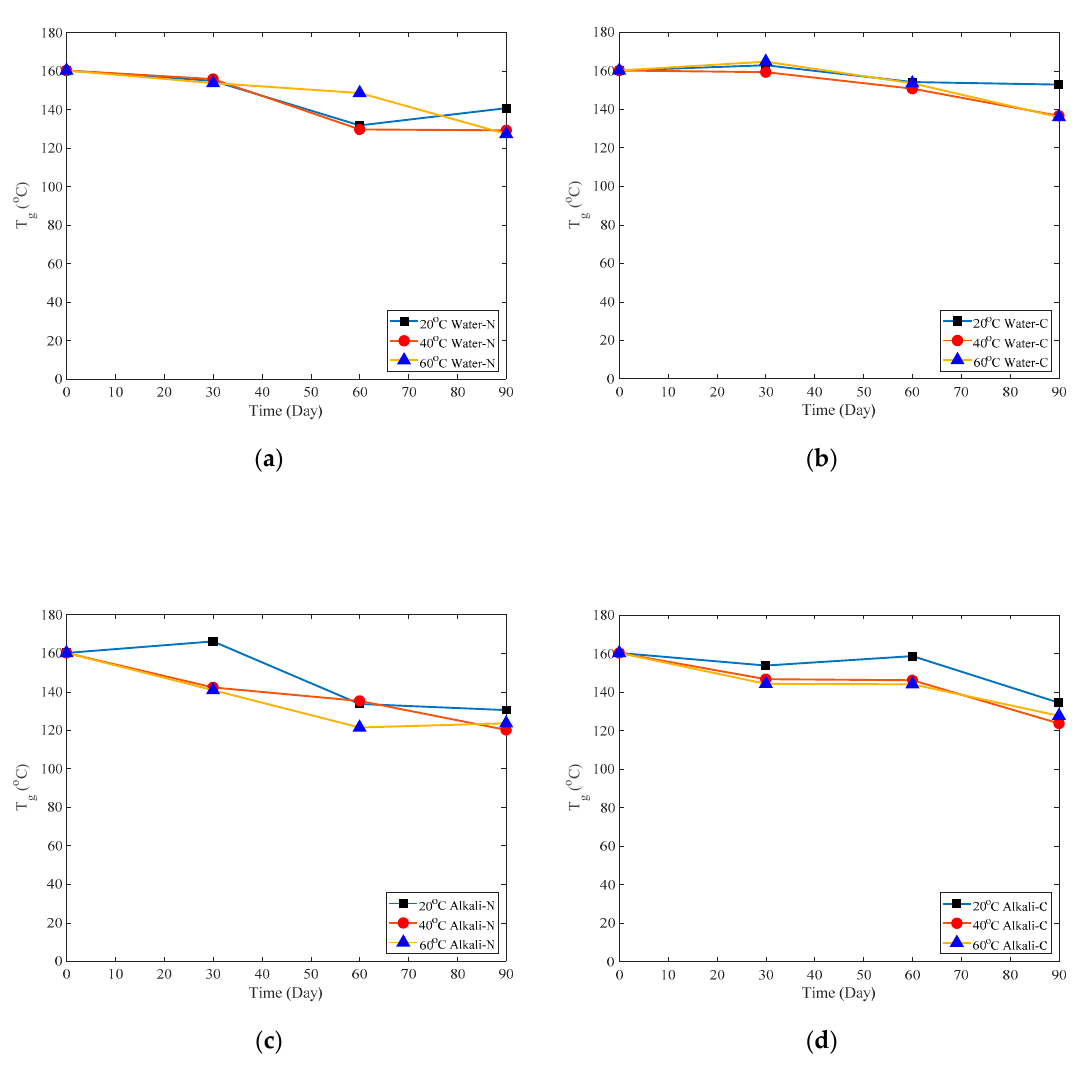
Figure 10. Variation of T g for: ( a ) Naked plate immersed in water; ( b ) Naked plate immersed in Alkaline solution; ( c ) Coated plate immersed in water; ( d ) Coated plate immersed in Alkaline solution.